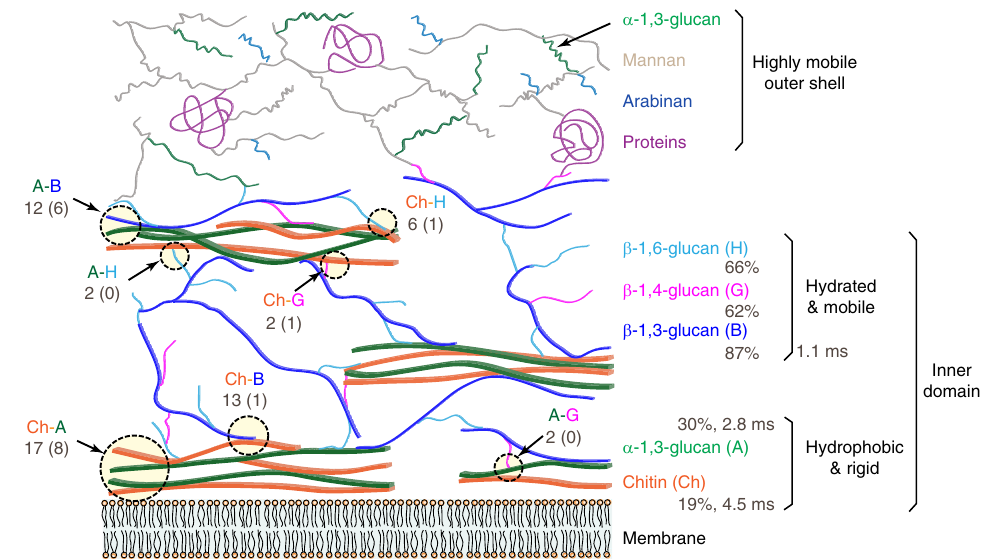
Fig. 7 Illustrative model of the supramolecular architecture of A. fumigatus cell walls. Dashline circles highlight the intermolecular interactions with the total numbers of NMR restraints indicated. The number of strong restraints is in parenthesis. The average hydration levels (percentage values) and the average 1 H-T 1 ρ relaxation times (in millisecond) of each polymer are also